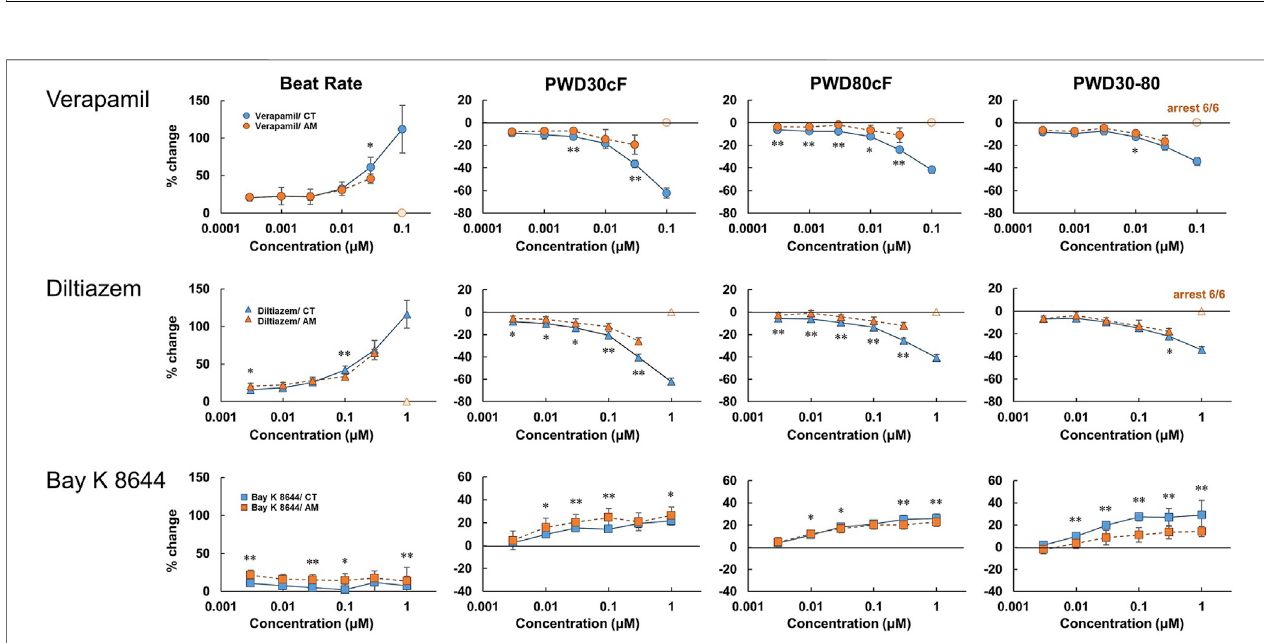
FIGURE5| Dose-responseofcalciumionchannelregulatorinCTandAM.ComparisonofMPparameters:beatrate,PWD30cF,PWD80cF,PWD30-80inCTand AMafterapplicationofcalciumionchannelblockerverapamilanddiltiazem,aswellastheselectivecalciumchannelactivator BayK8644.ErrorbarsrepresentSDofthe mean from the values of independent experiments. n (cid:2) 6. * p < 0.05, ** p < 0.01 for comparison of drug treatment of CT vs. AM. Bay K8644 data: reuse from the conference paper with permission (Honda, 2020).